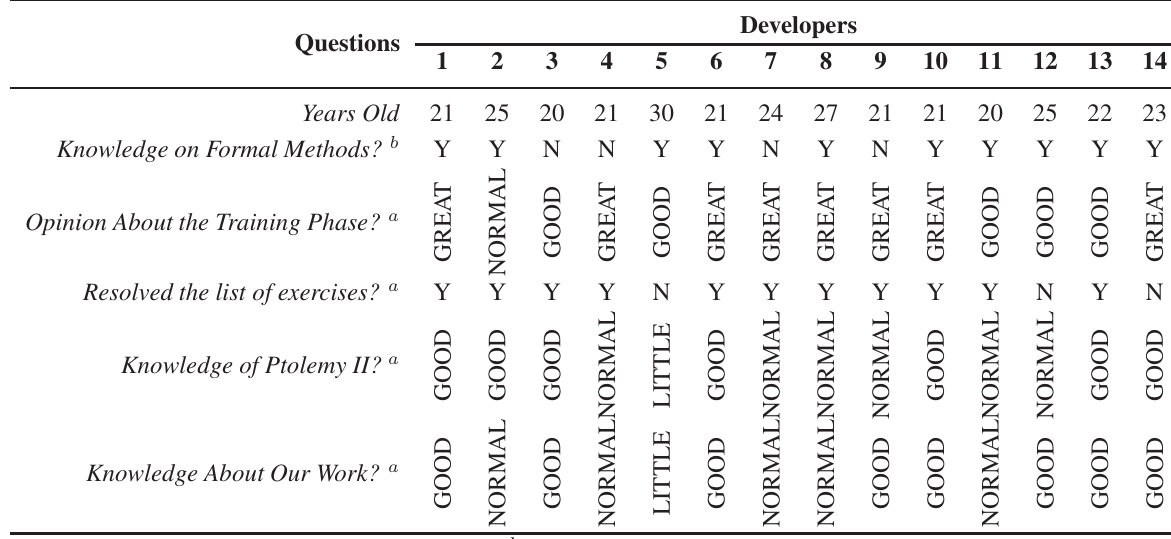
Table 4. Questionnaire to Identify the Developer’s